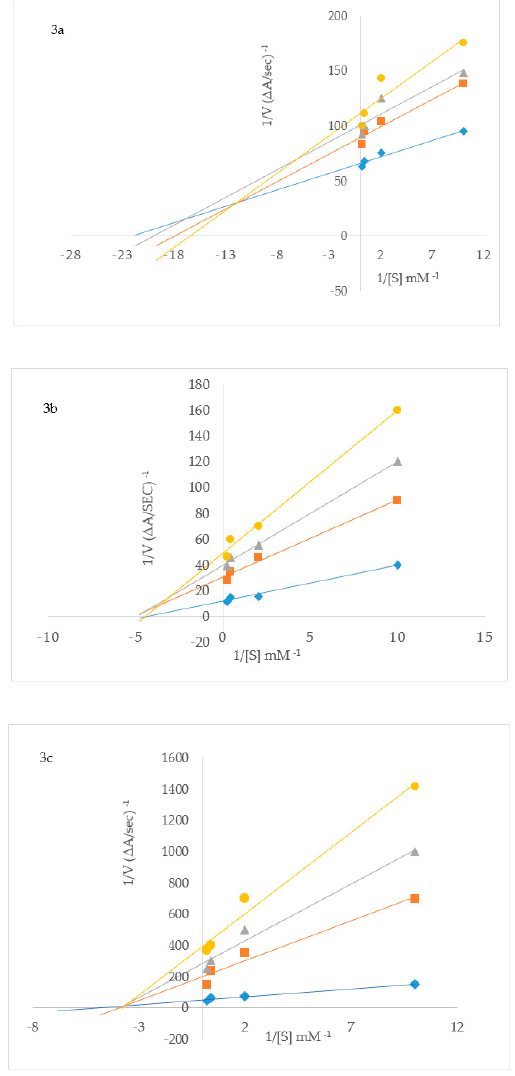
Figure 3. Lineweaver–Burk plots for inhibition of AChE by 3b ( a ) and BChE by 2h ( b ) and 3p ( c ). Blue symbols and fitted straight lines represent enzyme activity in the absence of inhibitor, while orange (2.5 µ M), grey (3.5 µ M) and yellow (5 µ M) represent various concentrations of inhibitor.